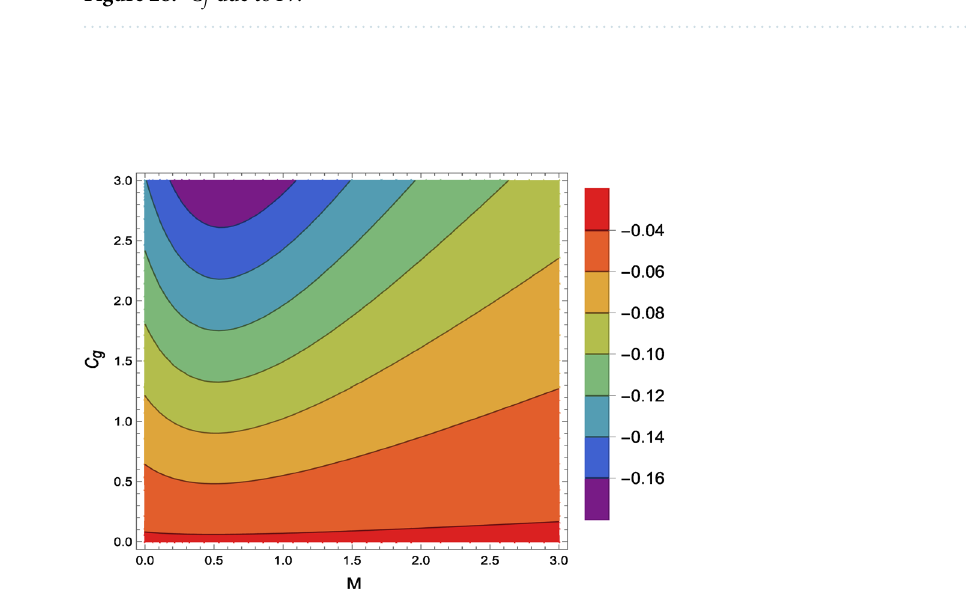
Figure 28. C f due to Fr .